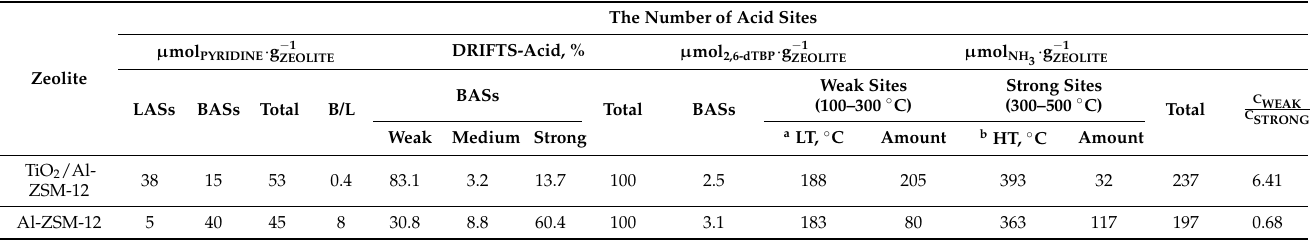
Figure 8. Main structural groups and Brønsted and Lewis acid sites in zeolites identified on the basis of IR spectra of adsorbed probe molecules: ( а , c ) FTIR-pyridine, ( b , d ) FTIR-2,6-di-tert-butylpyridine, ( e ) FTIR-deuteration acetonitrile, and ( f ) DRIFTS-acid. (B—Brønsted acid sites, L—Lewis acid sites, Py—physically adsorbed pyridine (absorption band maximum at 1443 cm − 1 ), L S —strong Lewis acid sites, L W —weak Lewis acid sites, B S —strong Brønsted acid sites, B W —weak Brønsted acid sites). Table 2. Acid characteristics of synthesized